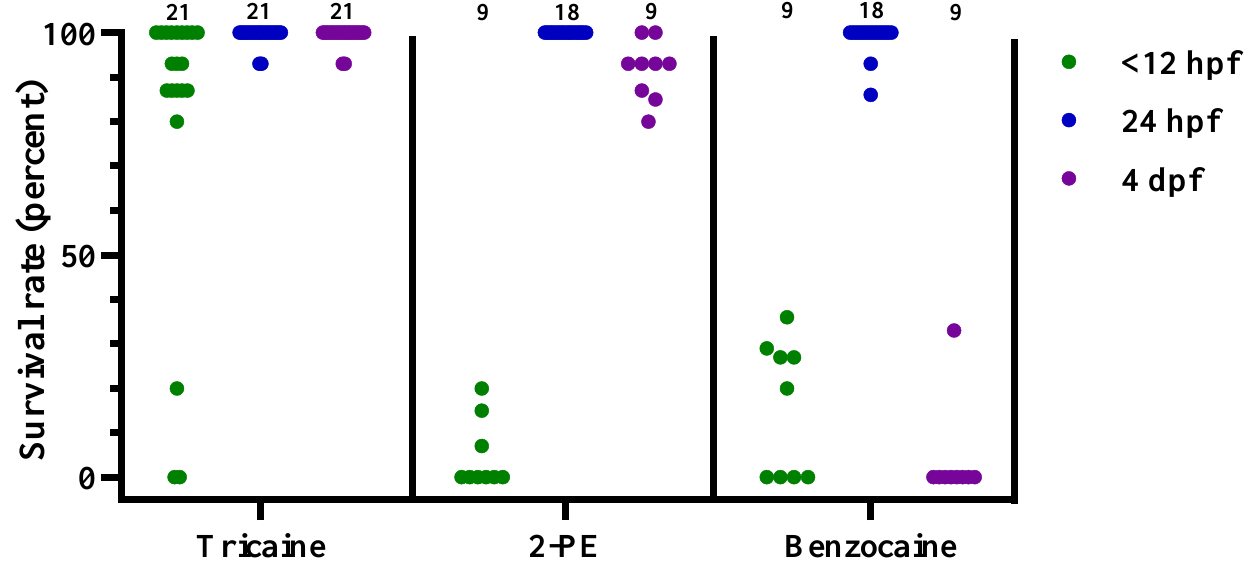
Figure 4. Survival rates for zebrafish following tricaine, 2-phenoxyethanol (2-PE), or benzocaine treatment, at 3 different developmental stages (<12 hpf, 24 hpf, and 4 dpf), presented as result per dish. Each dot represents one dish, with the total number of dishes per group indicated at the top of each column ( n = 9 – 21). hpf; hours post fertilization. dpf; days post fertilization.